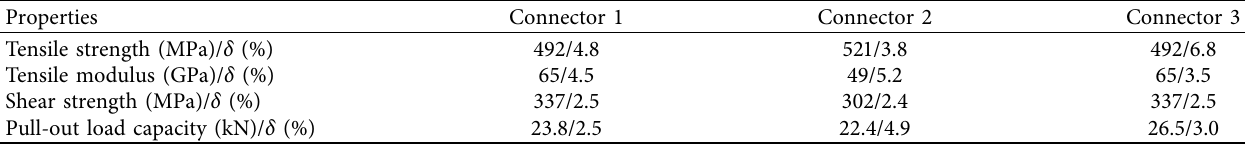
Table 1: Mechanical properties of the shear connectors.